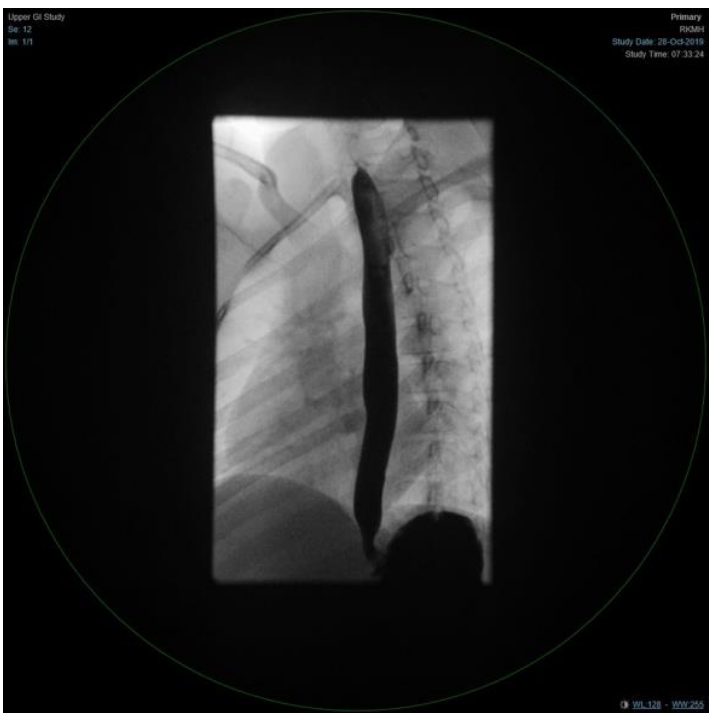
Figure 3. A chest CT scan, an axial view of lung window, showing cystic changes strongly consistent with bronchiectasis in lower lobes. (A = Anterior, P = Posterior, R = Right, L = Left).